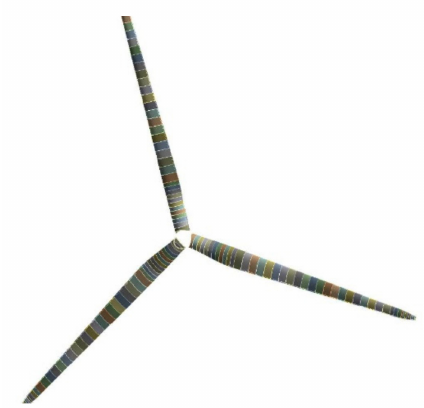
Figure 20. Blade solid geometry.